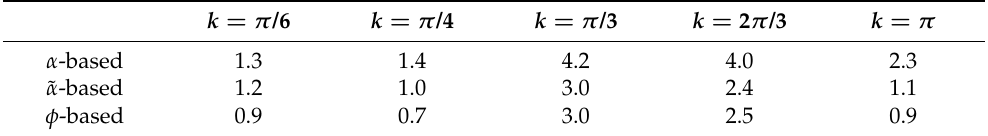
(cid:12) (cid:12) (cid:12) (cid:12) − ω analytical (cid:12) ω num (cid:12) / ω max , analytical ) in perturbation growth rate